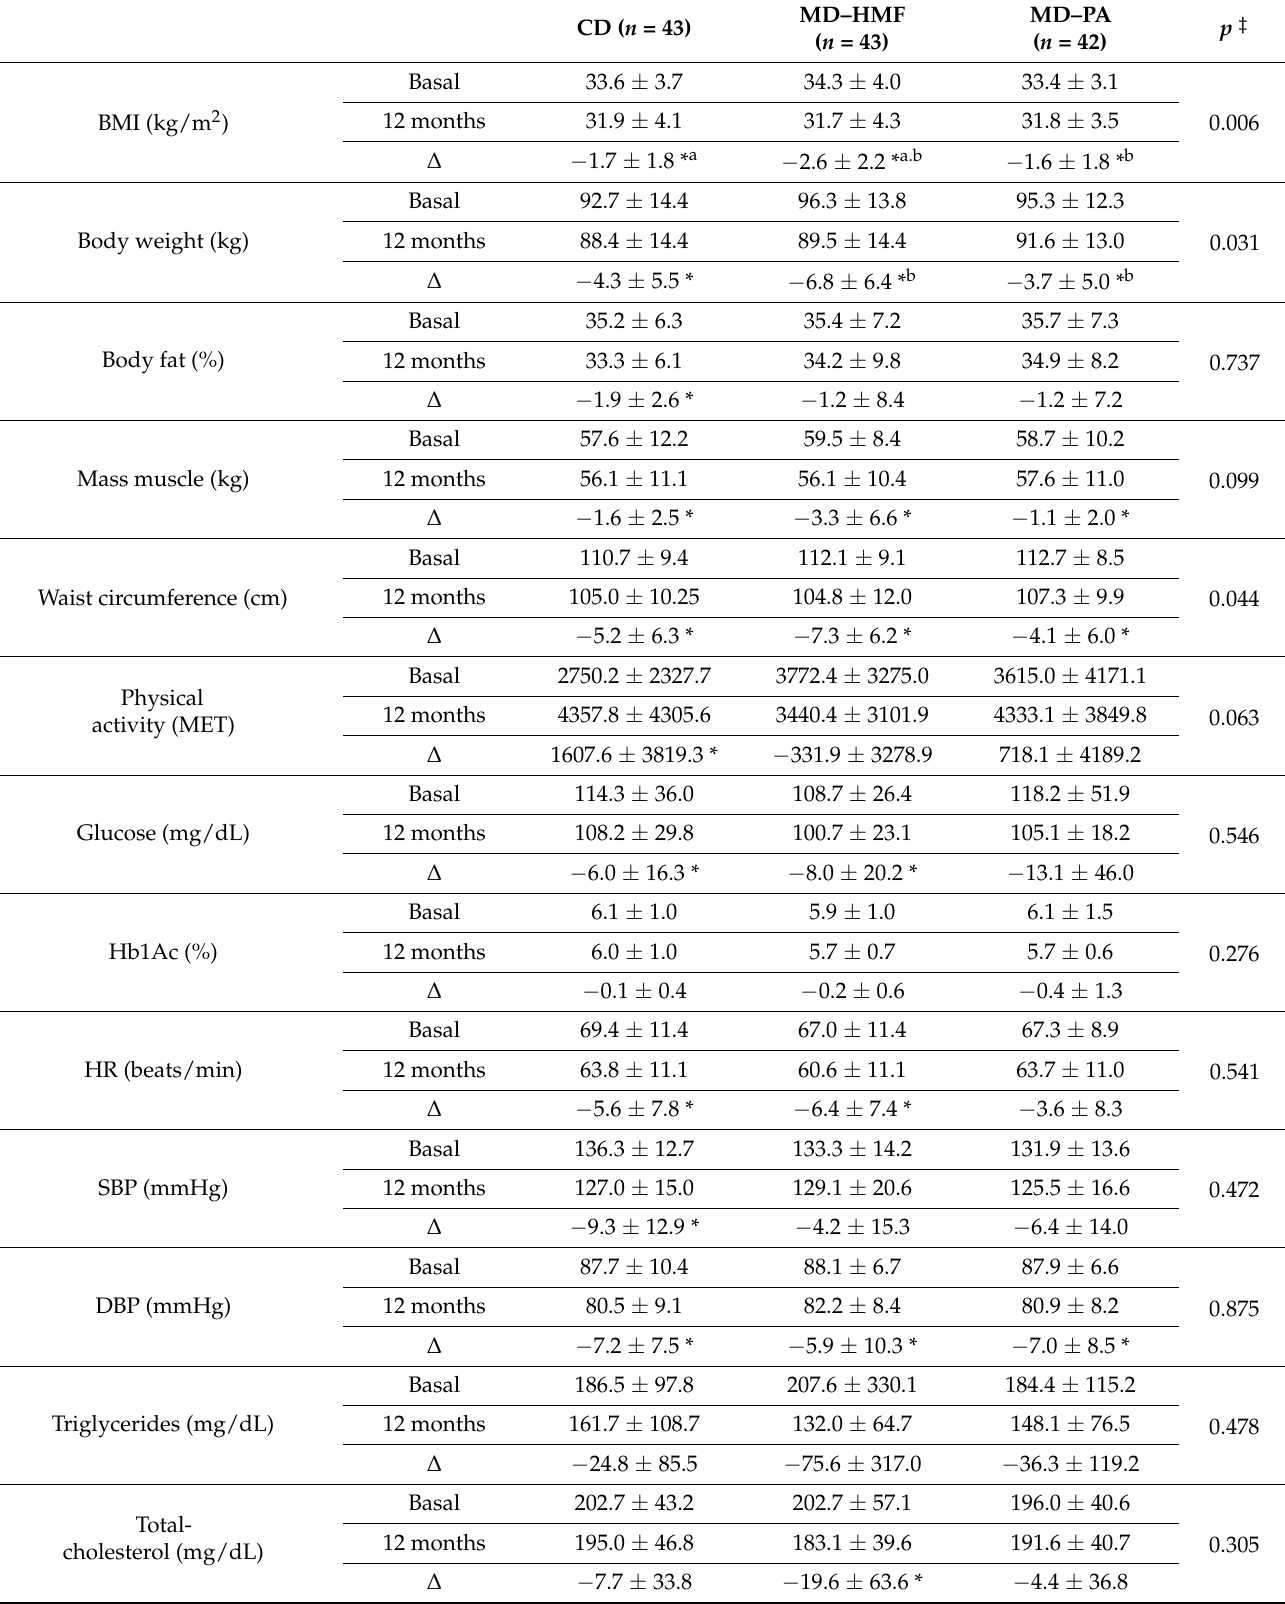
Table 4. Changes in anthropometric, metabolic, and liver parameters after 12 months of